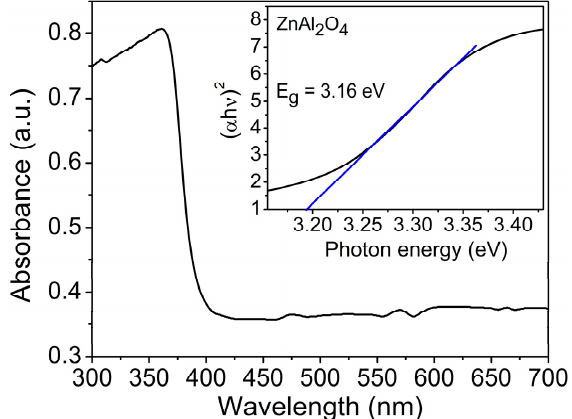
Figure 10. Optical absorption spectrum of the ZnAl 2 O 4 powders synthesized at 700 °C. The inset shows the curve ( α hv ) 2 versus hv . shows the curve ( α hv ) 2 versus hv